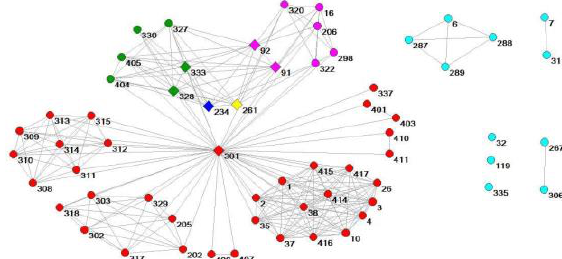
Fig.12. Agnès' network in 2004, with colours indi- cating the deconstruction stages